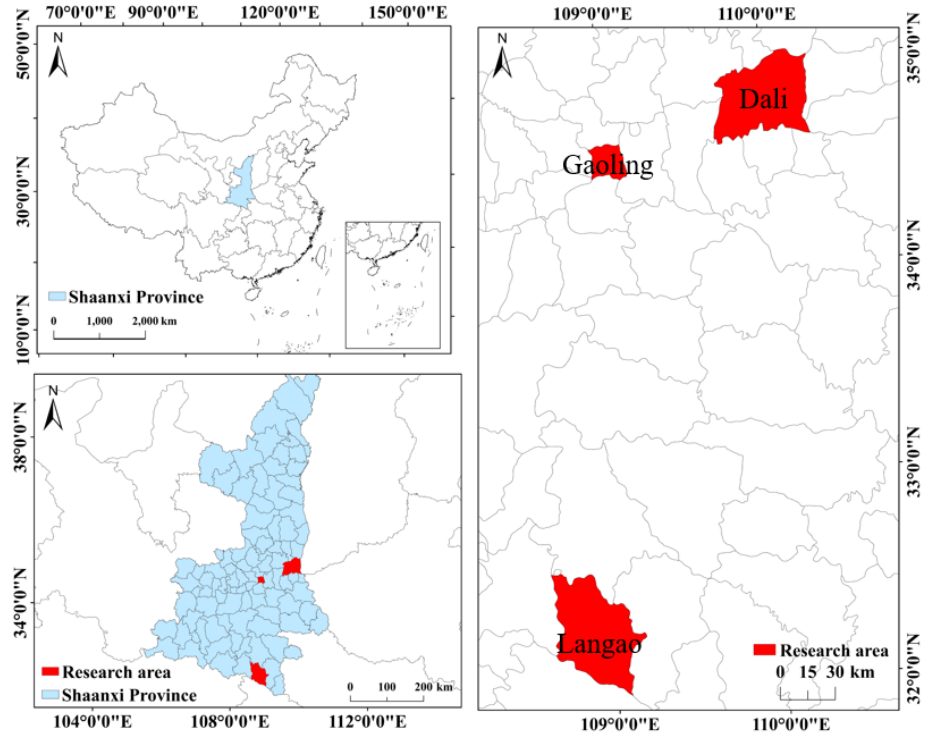
Figure 1. Map of the study area.